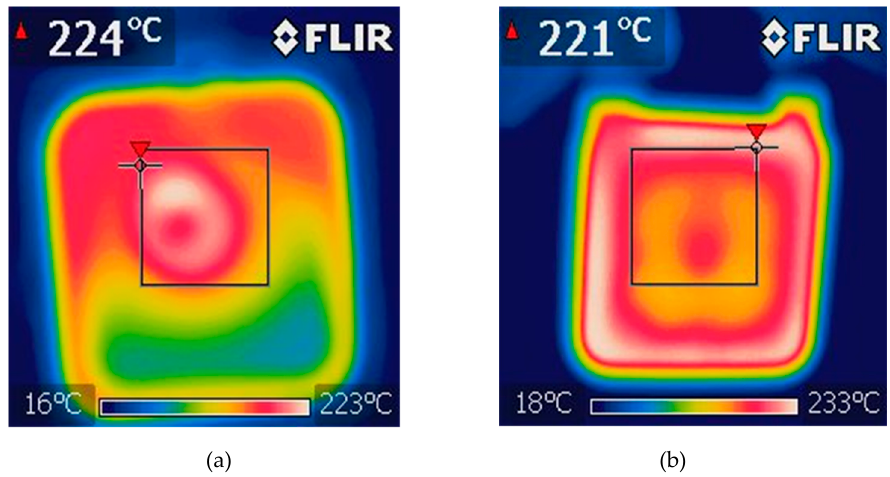
Figure 11. Temperature distribution map of the ZnO varistor after impulses. ( a ) Varistor block A1. ( b ) Varistor block A4.